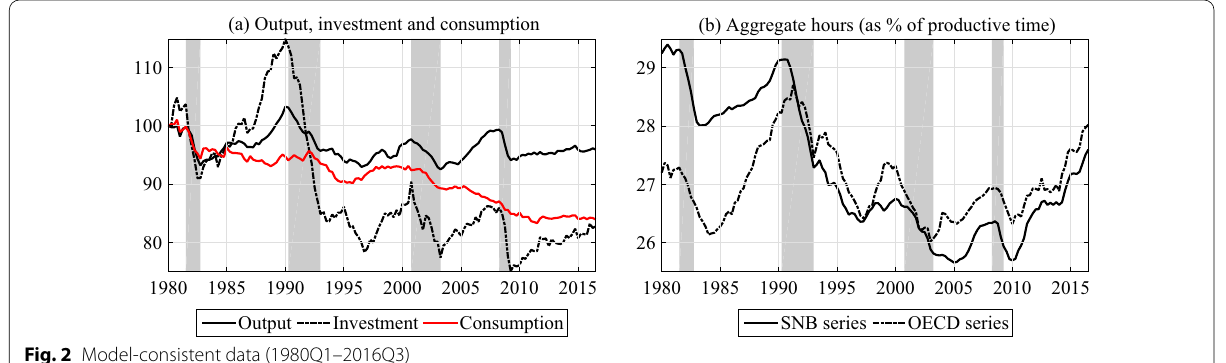
Fig. 2 Model-consistent data